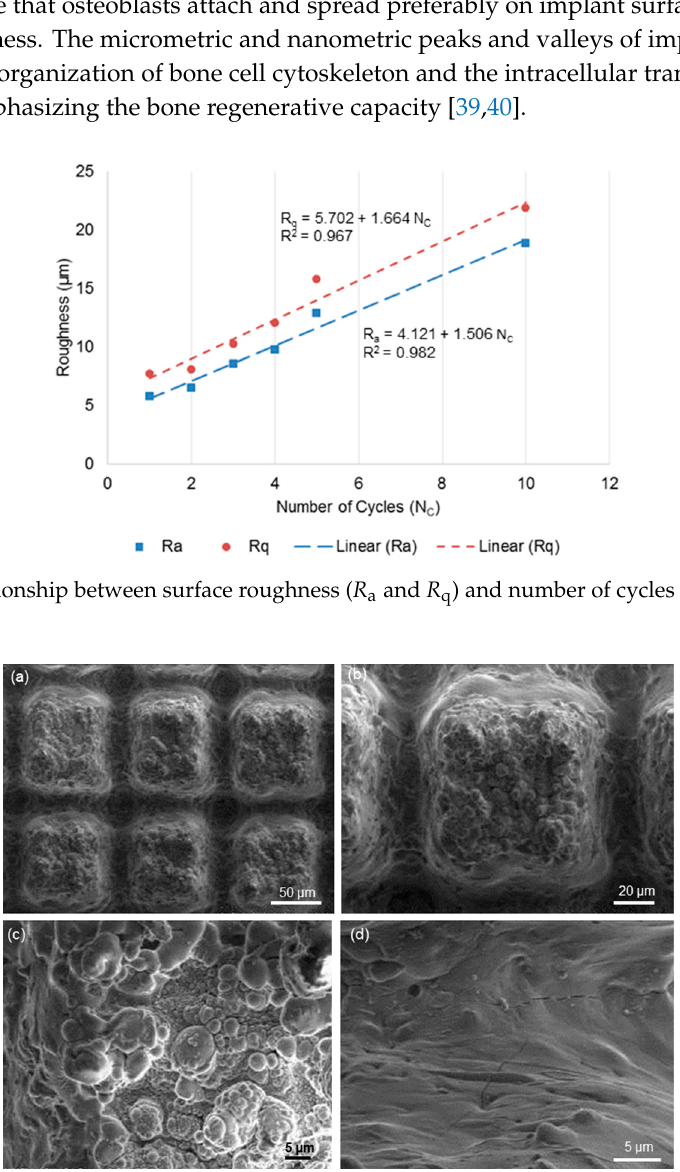
Figure 14. SEM micrographs of sample 5: ( a ) general view and ( b ) detail of the surface texture, ( c ) top surface of a hill and ( d ) detail of the area between two adjacent hills.